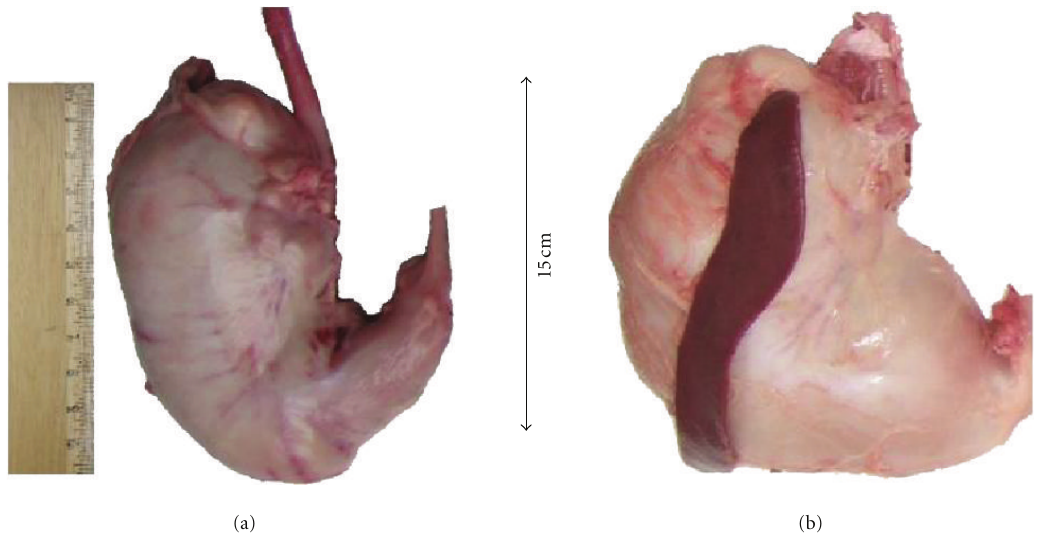
Figure 1: Photograph of the intact stomach at post mortem of the (a) Muong indigenous and (b) The Vietnamese wild pigs. Note the mark di ff erences in terms of shape where it is much more circumscribed in (b). In general, the shape of the stomach of the Muong pig closely resembles that of the domestic